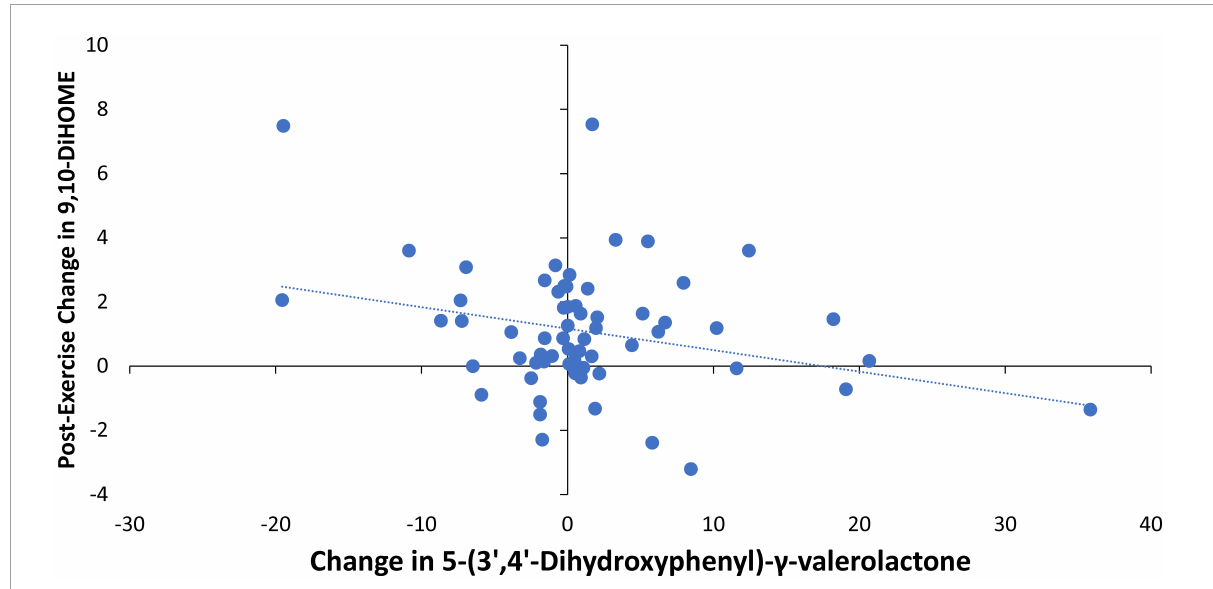
FIGURE6 Pearson correlation scatterplot between the change in urine 5-(3 (cid:48) ,4 (cid:48) -dihydroxyphenyl)- γ -valerolactone (pre- and post-4-weeks supplementation with almonds or cereal bars) and the post-exercise change in plasma 9,10-DiHOME ( r = –0.288, p = 0.021).